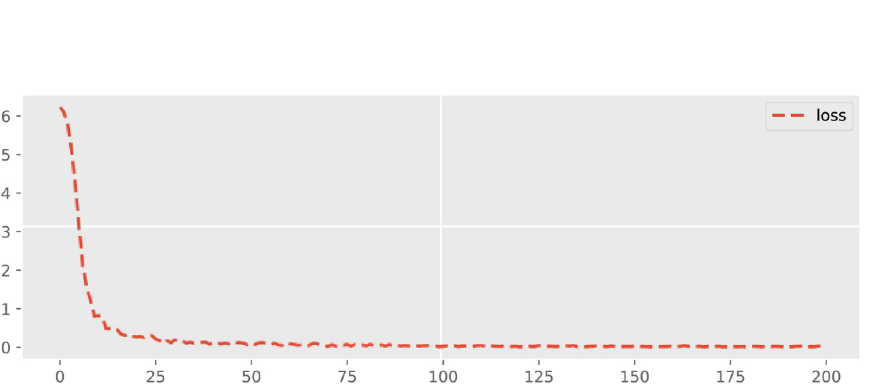
Fig 11. Validation loss across 200 epochs for Offshore Windfarm 3 based on adopted fine-tuned forecasting settings.